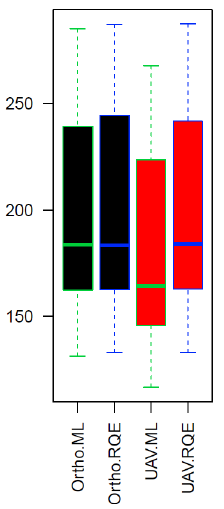
Figure 7. Evaluation of peak flows (Ls − 1 ) for the 13 most intense rain events (prior